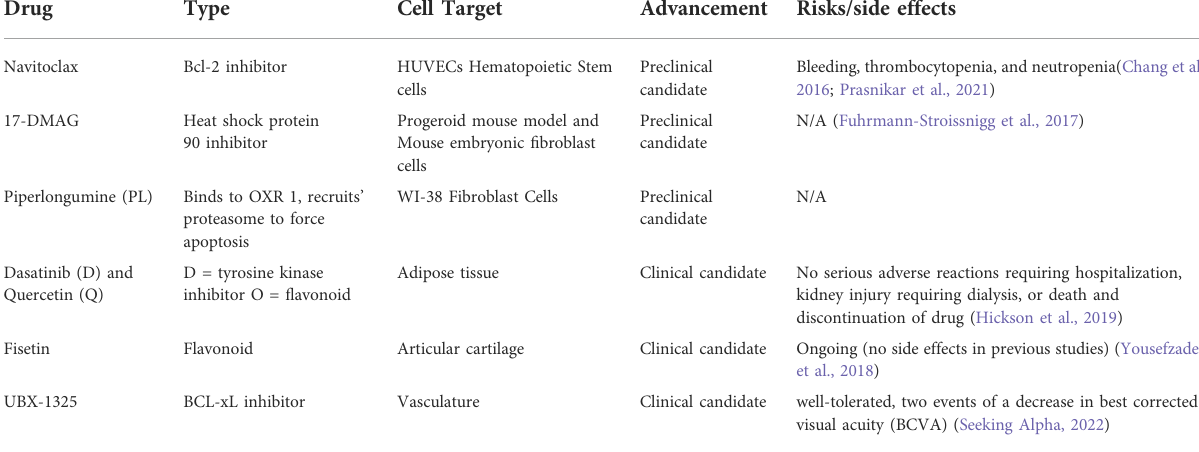
TABLE 1 Summary of senolytic candidate